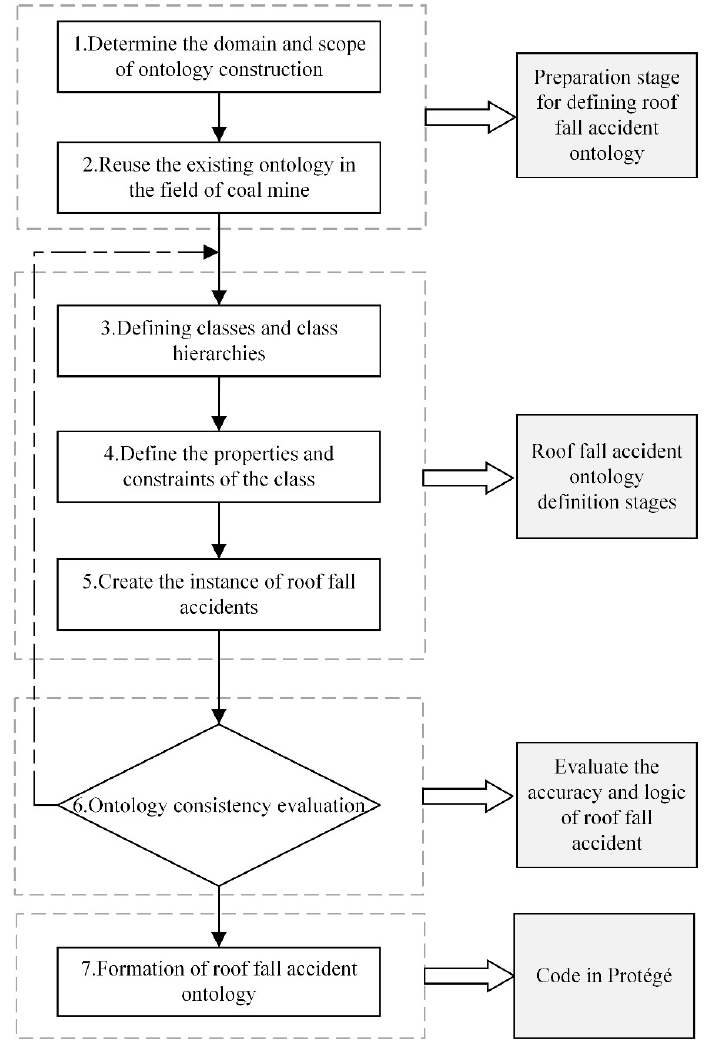
Figure 4. The construction process of the ontology for roof fall accidents.